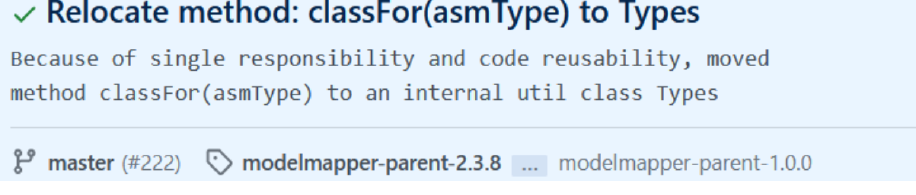
Figure 2. A sample instance of our